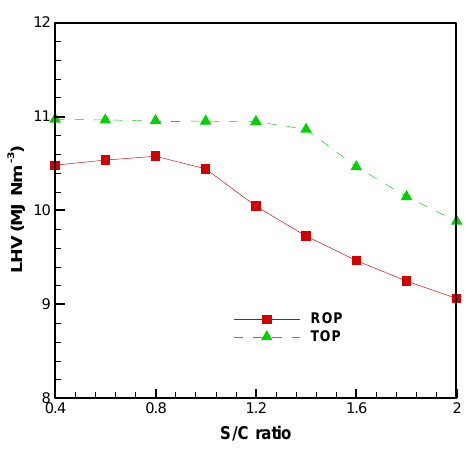
Figure 4. Effects of the S/C ratio on distributions of lower heating